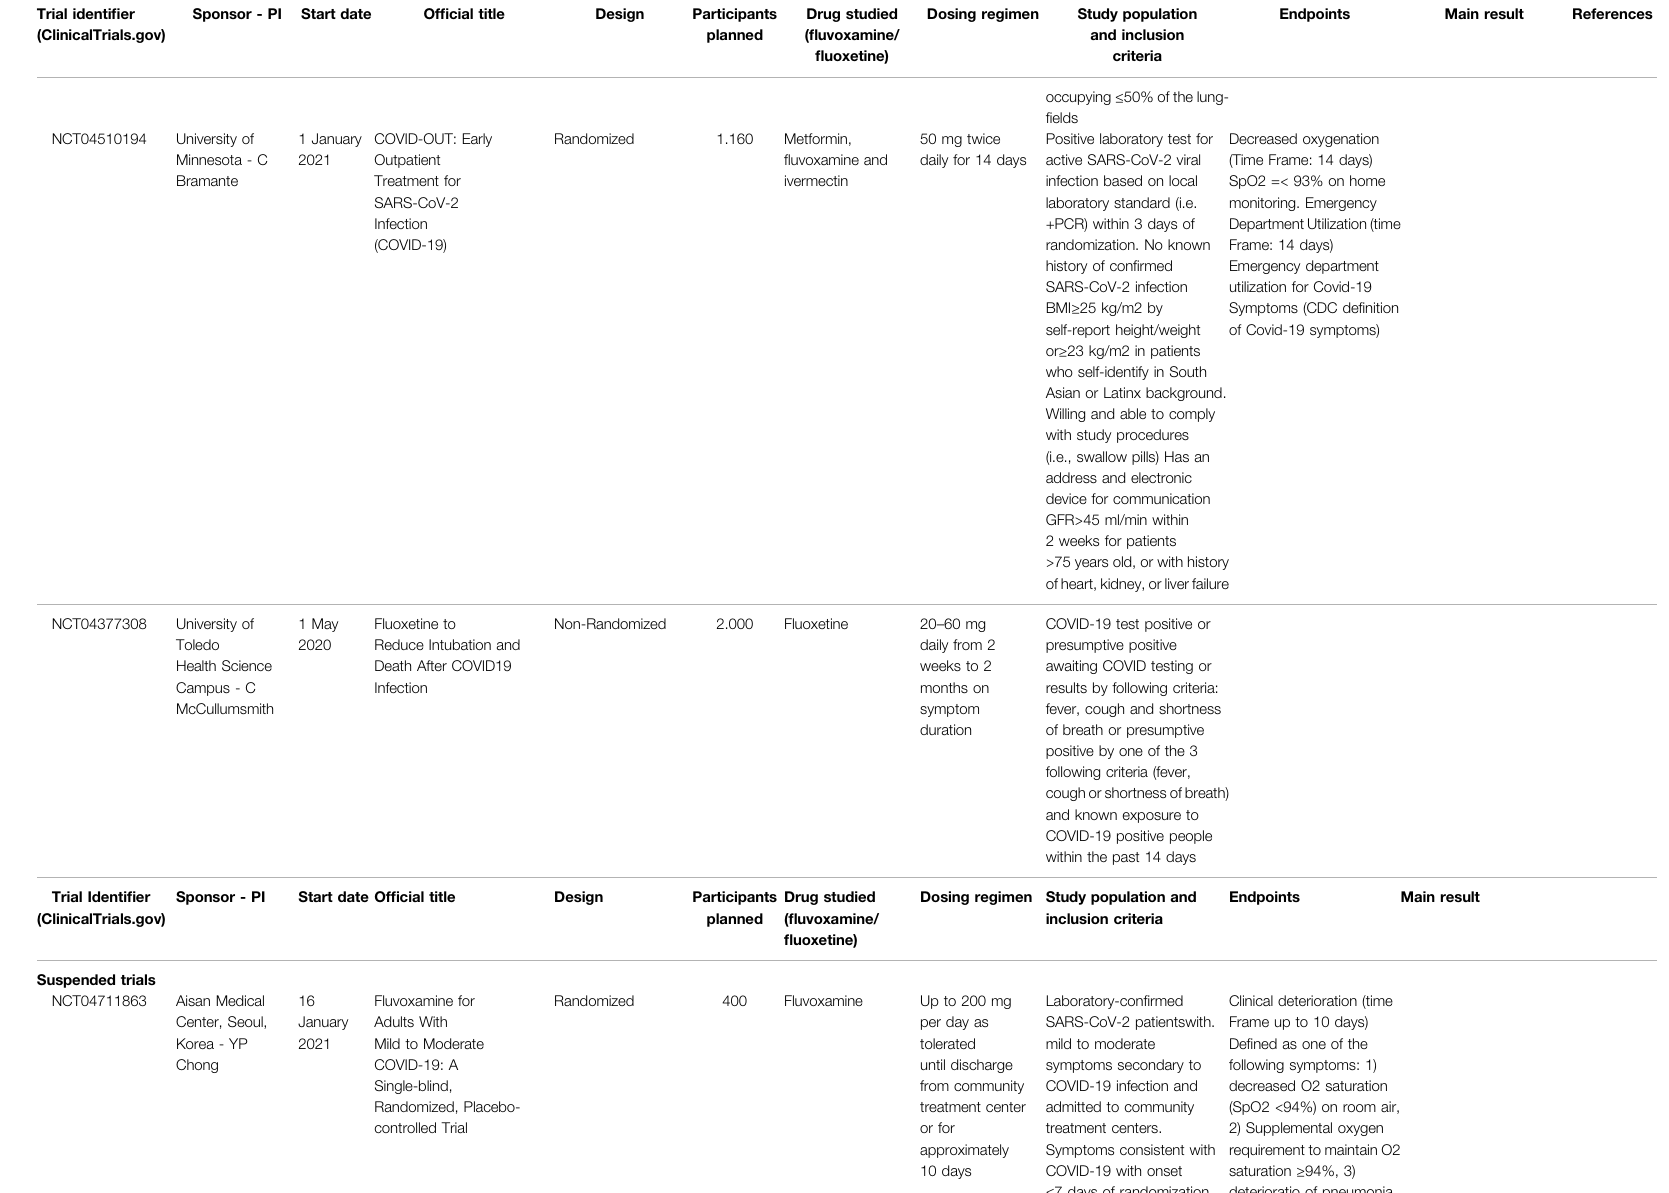
TABLE 1 | ( Continued ) Main features of completed, ongoing, suspended and withdrawn trial on fl uvoxamine and fl uoxetine in patients with